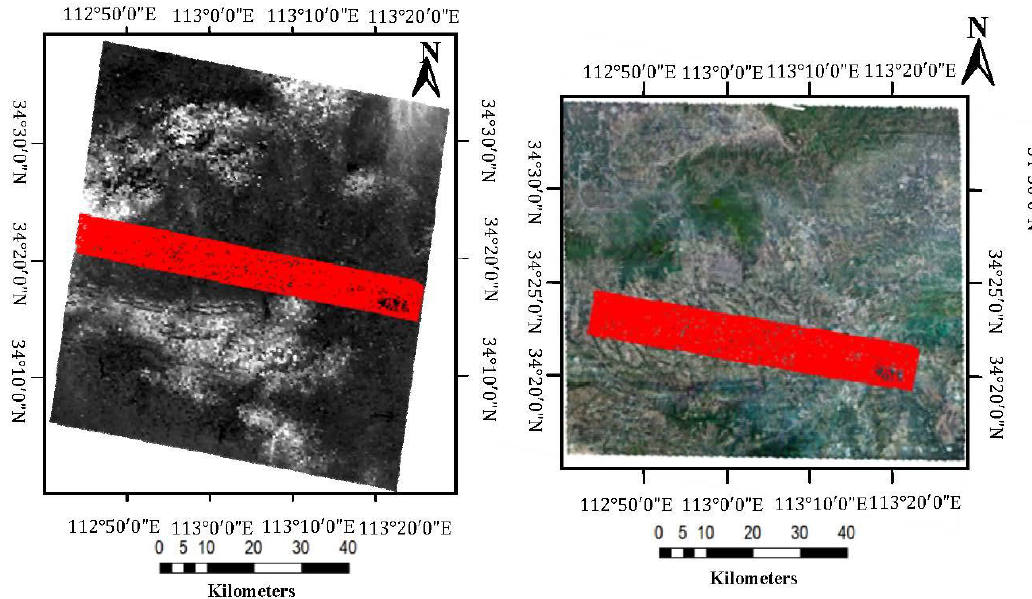
Figure 4. Matching result for ZY1-02C’s panchromatic image and the reference orthophoto: ( left ) ZY1-02C’s panchromatic image; ( right ) orthophoto.